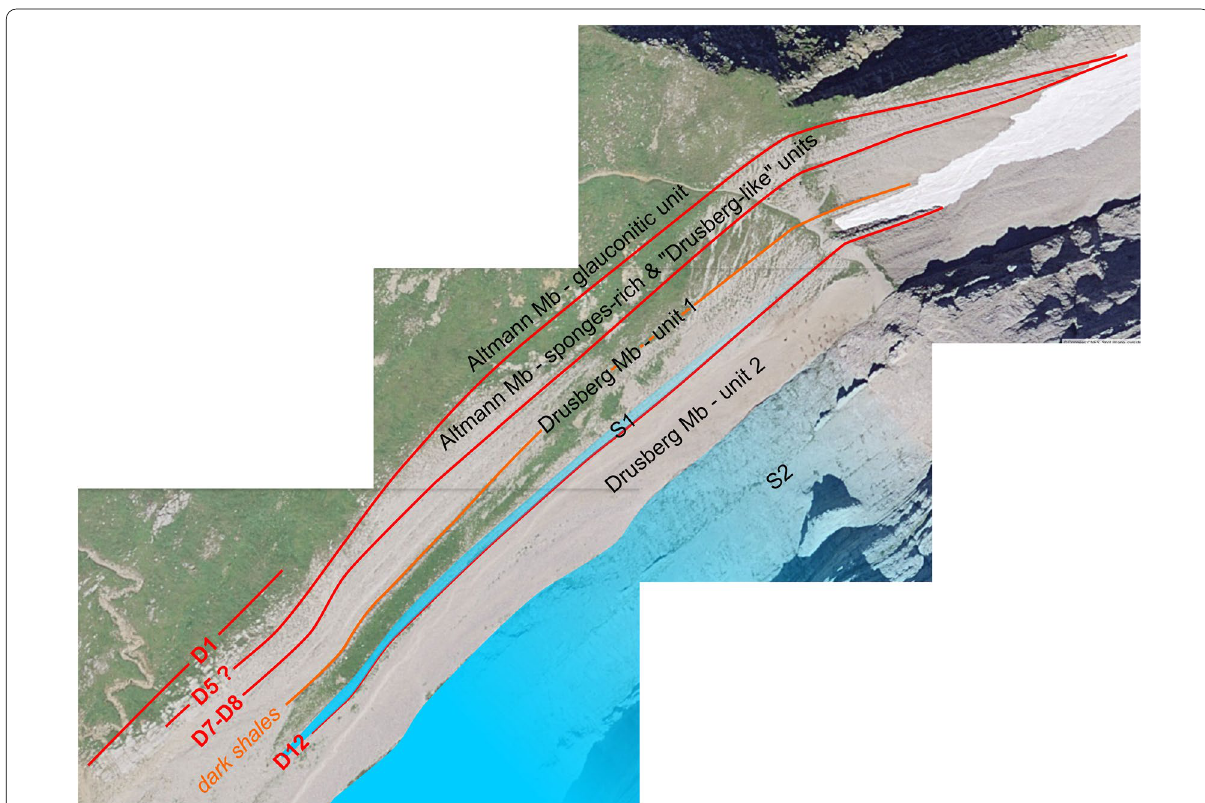
Fig. 8 Orthophoto (© swisstopo) of Altmannsattel on which are reported the main lithostratigraphic units, key beds, and discontinuity surfaces. Note the lateral pinching toward the northeast of the sponge-rich and “Drusberg-like” units in the upper part of the Altmann